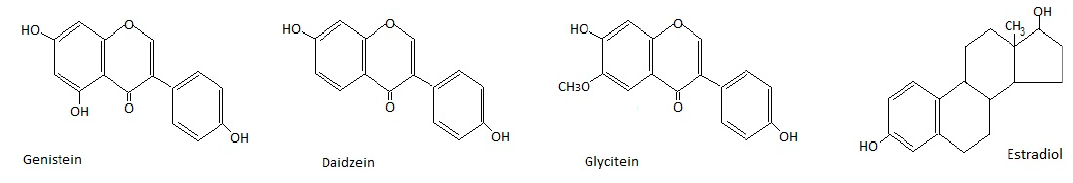
Figure 2. Chemical structures of isoflavones and 17- β -estradiol.